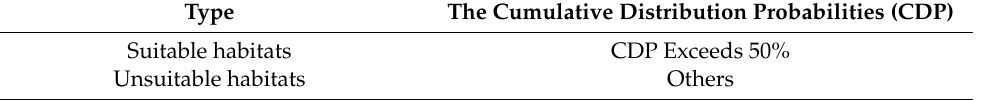
Table 1. Habitat classifications and cumulative distribution probabilities for wintering geese at Poyang